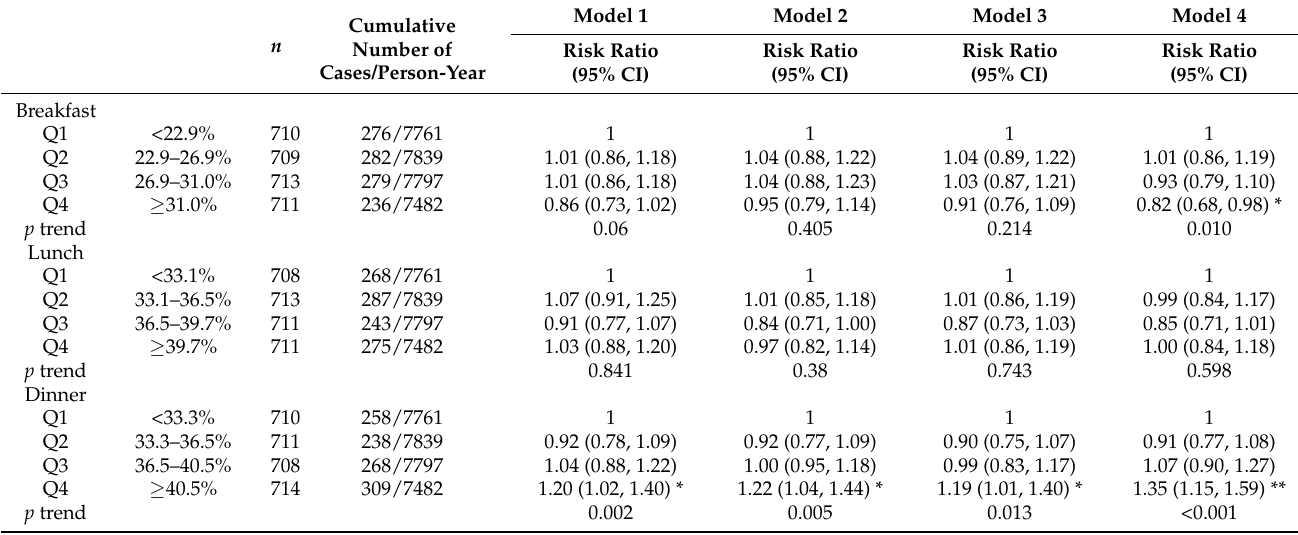
Table 3. Association between cumulative averages of proportions of energy from breakfast, lunch, and dinner and risk of dyslipidemia ( n = 2843) 1